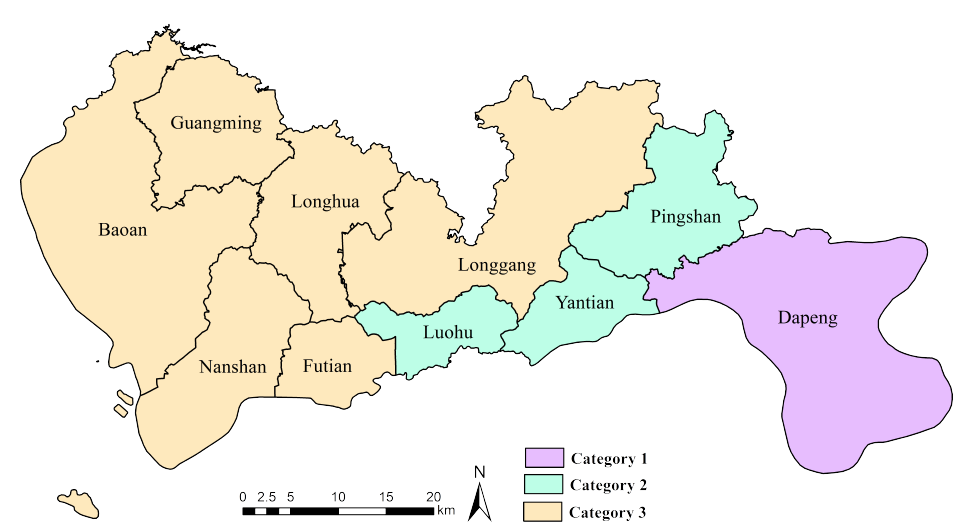
Figure 6. The map between different diffusion coefficient categories and Shenzhen’s administra- tive regions.